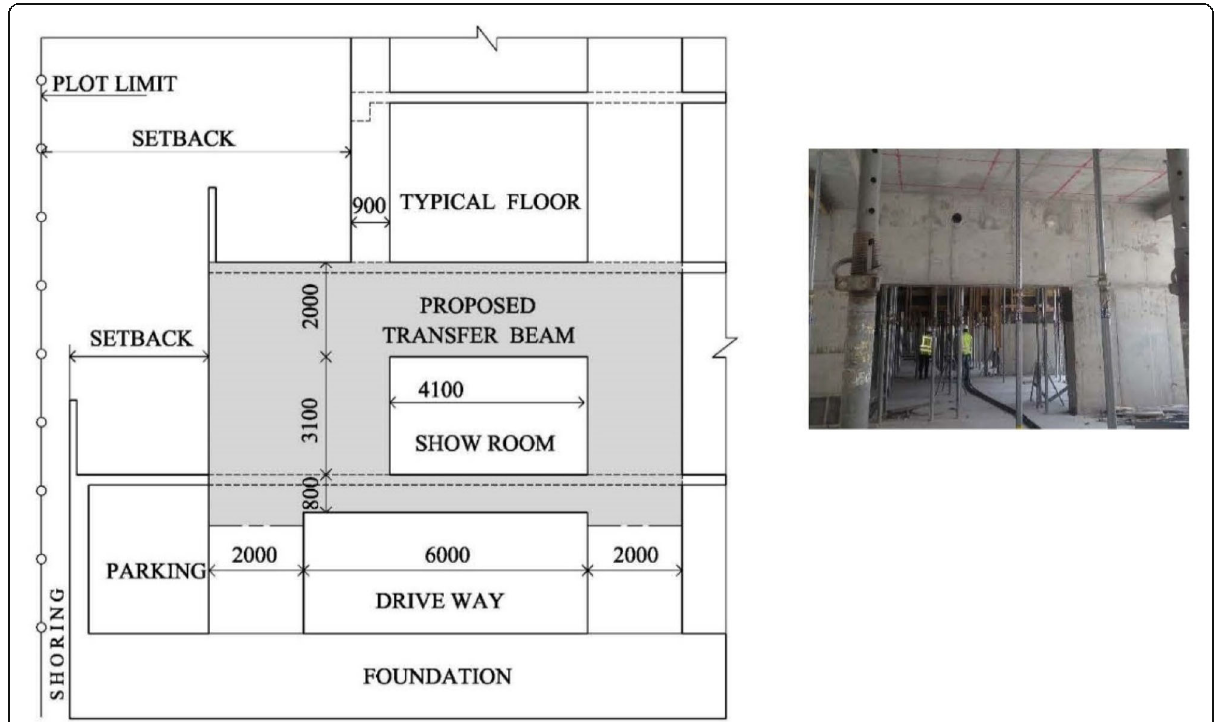
Fig. 1 Dimensions of the proposed transfer beam and site photo for the top